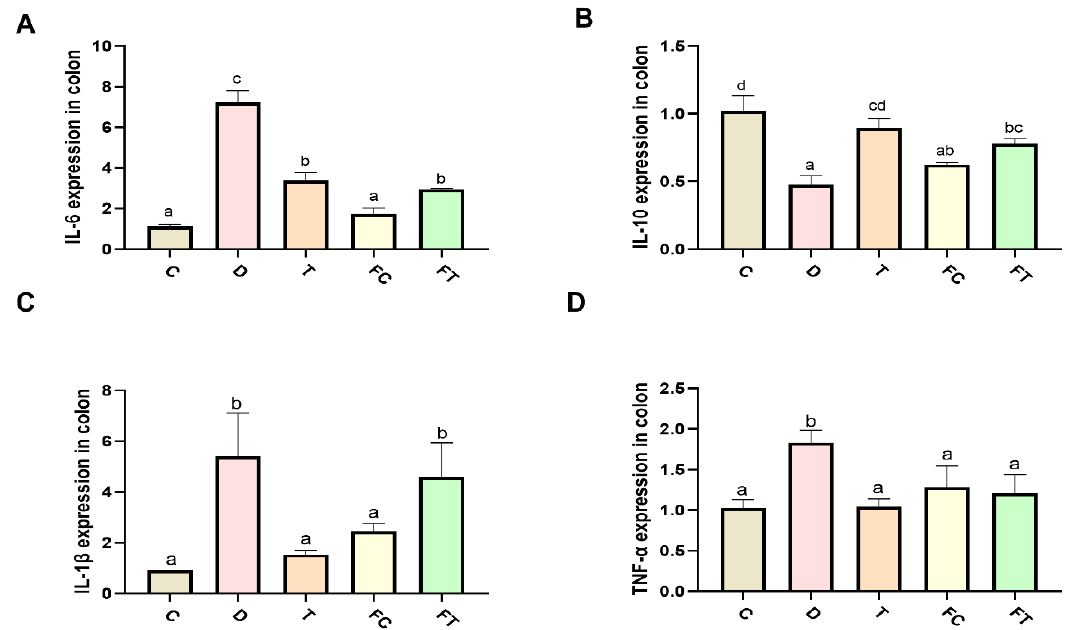
Figure 4. Taxifolin and FMT treatment reduced the expression level of inflammatory cytokines in colon tissue in DSS treated mice. The expression level of inflammatory cytokines IL-6 ( A ), IL-1 β ( B ), TNF- α ( C ), IL-10 ( D ) in each group were detected. Data are mean ± SEM ( n = 7). The letters abcd are significant markers, and any difference with one of the same marker letters is not significant, and any difference with different marker letters is significant.